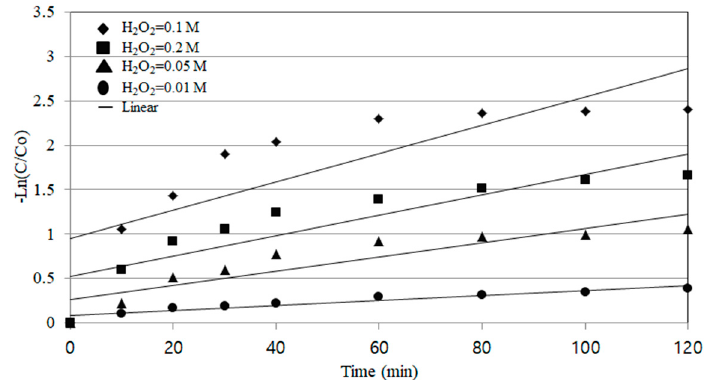
Figure 5. Effect of H 2 O 2 dosage on COD removal in photo-assisted Fenton oxidation (pH = 3.5, Fe 2+ = 0.01 M, UV 254 intensity = 3.524 mW/cm 2 ).